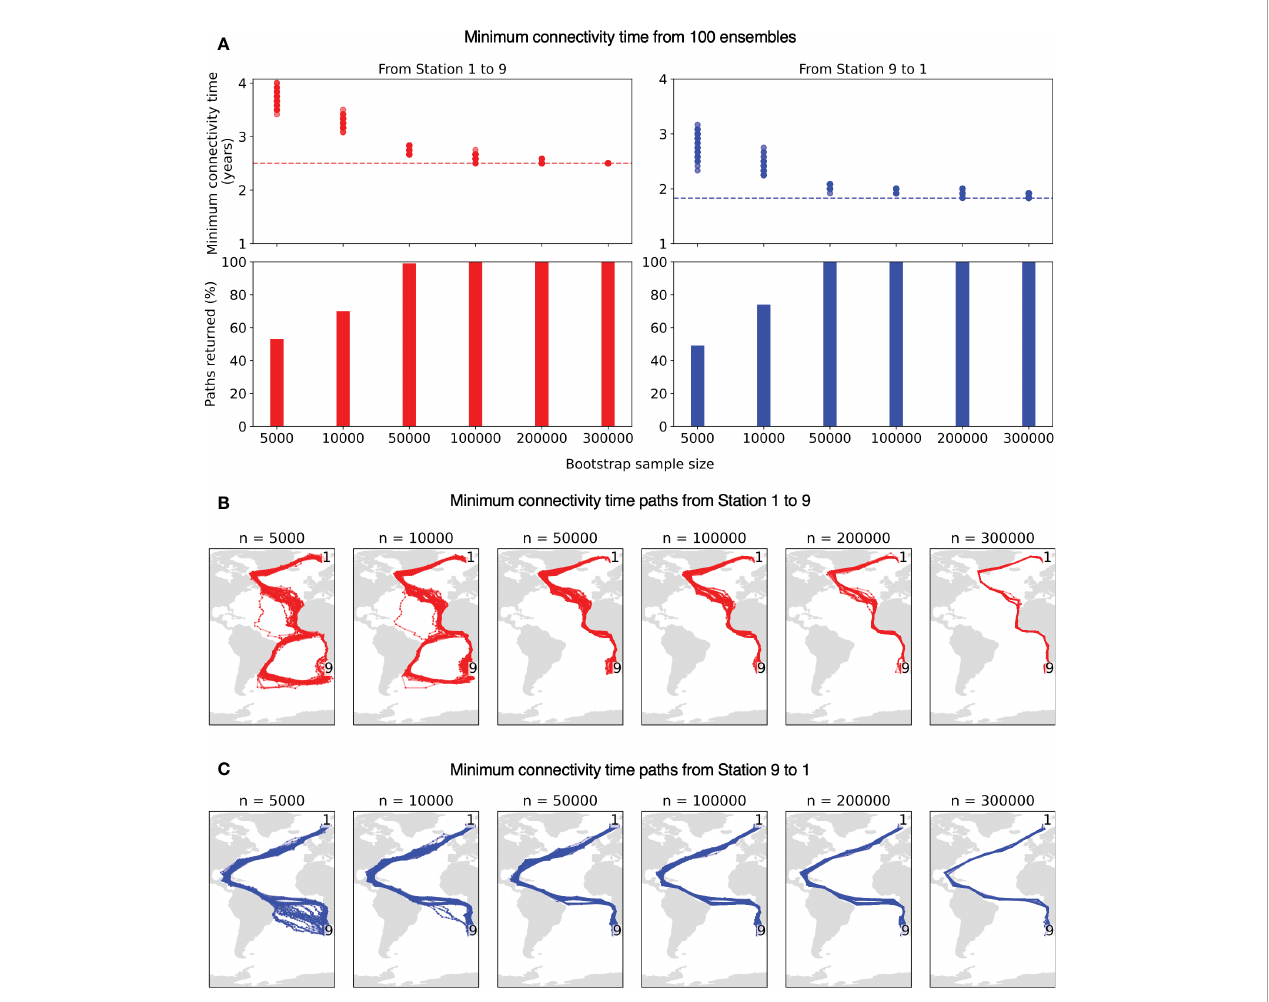
FIGURE 6 (A) Minimum connectivity time and (B – C) paths between Station 1 to 9 obtained from 100 bootstrap ensembles (surface simulations) each for different sample sizes. Red indicates connectivity from Station 1 to 9 and blue from Station 9 to 1. The bar plot in (A) represents the percentage of existing paths returned from the ensembles. The dashed horizontal lines represent minimum connectivity time from full set of 375,570 particles in respective cases, same as Figure